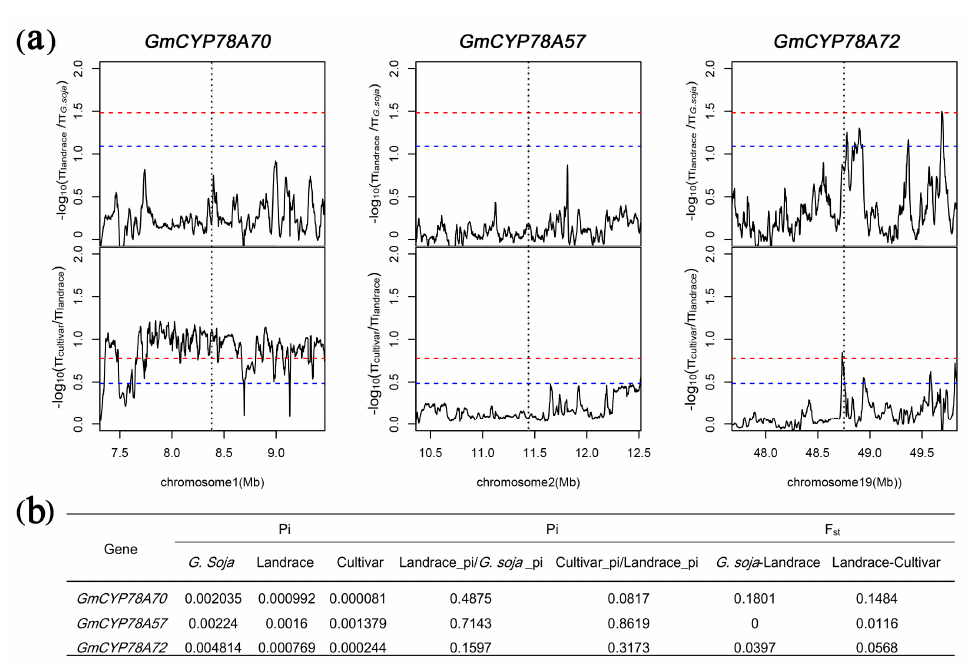
Figure 7. Selective pressure analysis for GmCYP78A s. ( a ) π ratios of the GmCYP78A s regions between different soybean populations. The red and blue dotted lines respectively represent the top 1% and top 5% thresholds selected to determine the region under evolutionary selection. The gray vertical lines correspond to the location of each GmCYP78A . ( b ) Index values relate to selective sweep in coding regions of GmCYP78As .